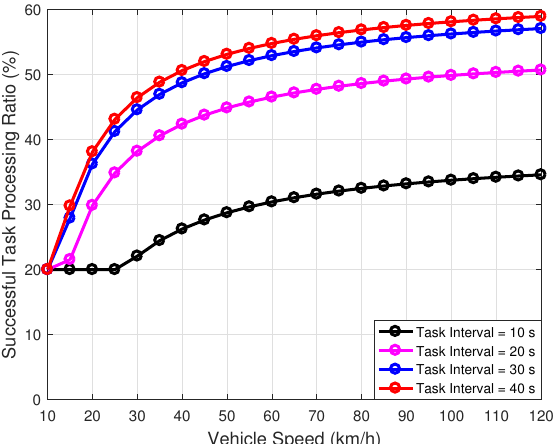
Figure 12. Comparison of the successful task processing ratio with respect to the vehicle speed under different task